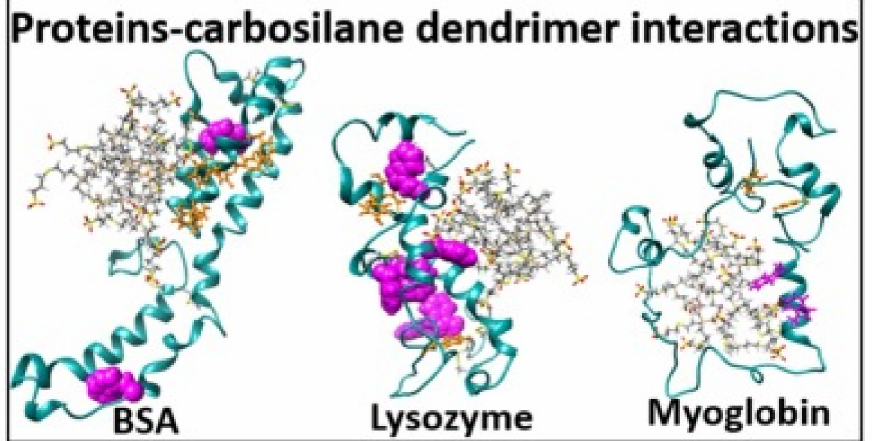
Figure 3. Structures of the complexes between sulphonate-terminated carbosilane dendrimers and corresponded protein obtained by MD. Reprinted with permission from ref. [88]. Copyright 2017,